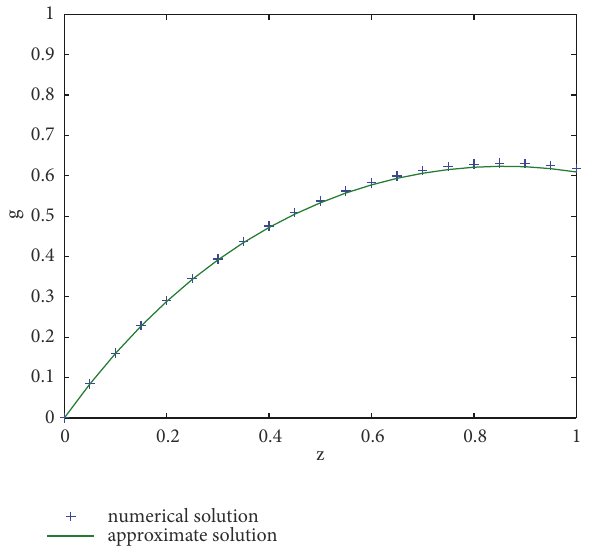
Figure 10: The comparison of the results of approximate solution and numericalsolution for 𝛼 = 3.0 , 𝑛 = 1.0 , 𝑘(𝑧) = 𝑧 , ℎ(𝑧) = (1−𝑧) 3 .